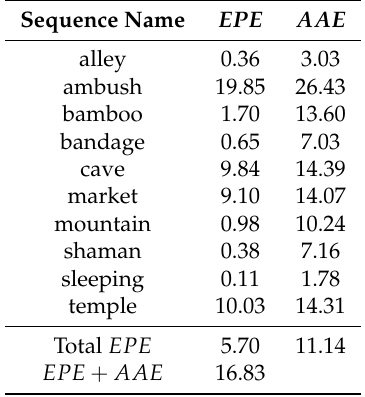
Table 15. Summary of results. The end point error and average angular error obtained by the combination of uniform and large gradients in the MPI-Sintel training set.